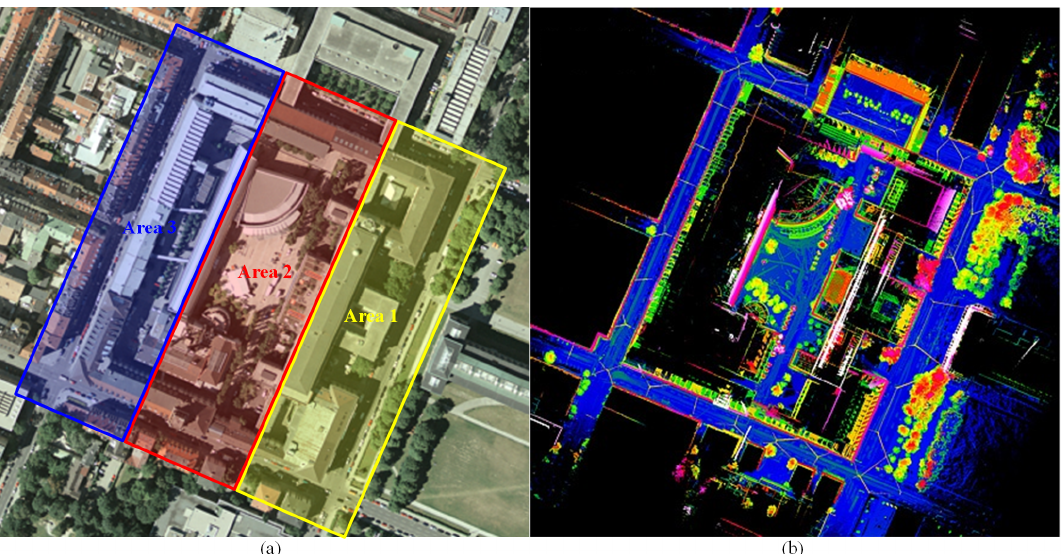
Figure 3. Measured MLS point clouds. ( a ) Aerial image of the measured TUM city campus. ( b ) Aggregated MLS point clouds colored with respect to height.